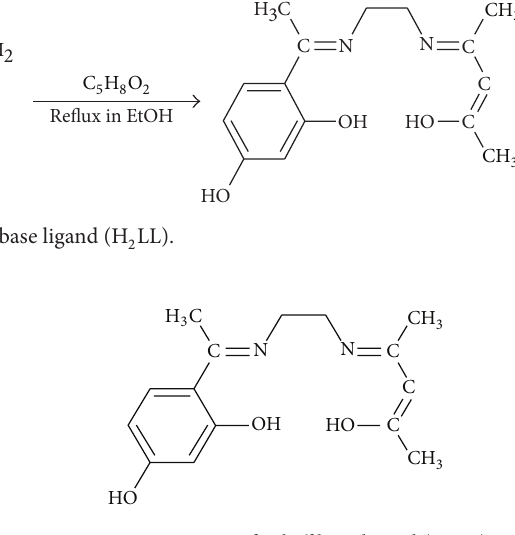
Figure 1: Structure of Schiff base ligand (H 2 LL).